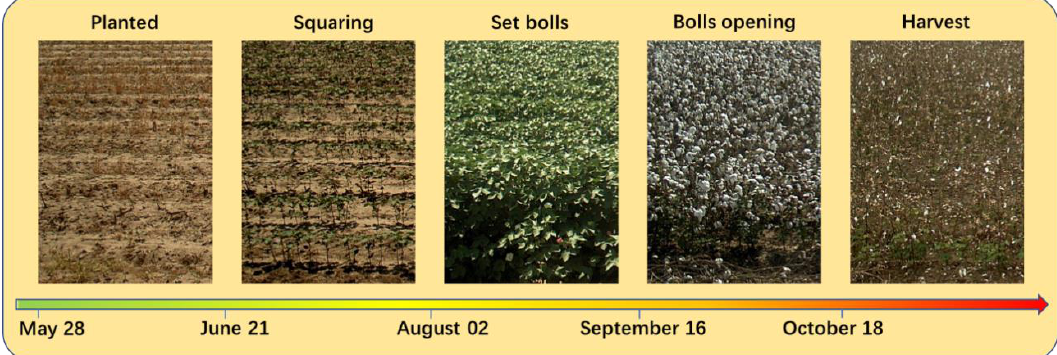
Figure 3. The phenological stages of cotton nearby MO-08.